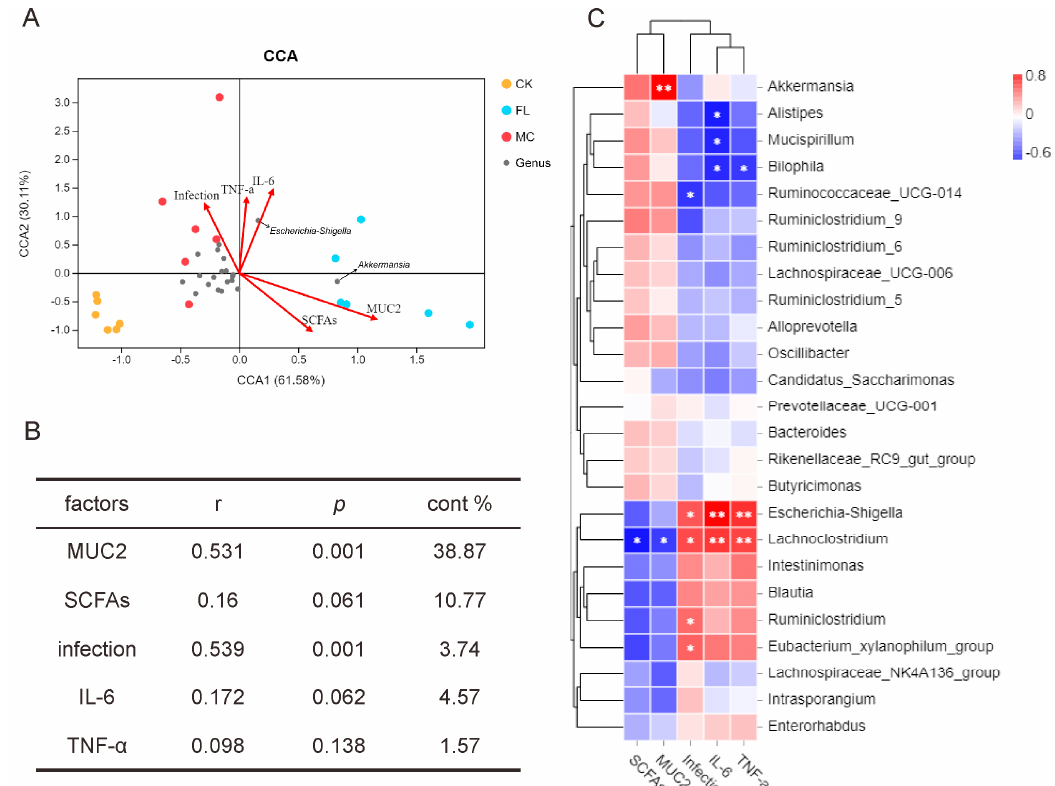
Figure 4. Correlation analysis of environmental factors. ( A ) Canonical correspondence analysis (CCA) analysis of microbial population distribution and environmental factors. Environmental factors are marked by arrows. The angle between the arrow line and the sorting axis indicates the correlation between environmental factors and the sorting axis. Environmental factors with a longer arrow had a higher correlation with the distribution of intestinal microbiome. ( B ) The significance of environmental factors was analyzed by envfit function. r is the determining coefficient of environmental factors on bacterial distribution; the larger the r value, the greater influence this environmental factor has on microbiome distribution. p is the significance level of correlation test. ( C ) As shown in the Spearman correlation thermogram, there were significant differences in the abundance of bacteria between different environmental factors. The colors range from blue (negative correlation) to red (positive correlation). A significant correlation is indicated by * p < 0.05 and ** p < 0.01.